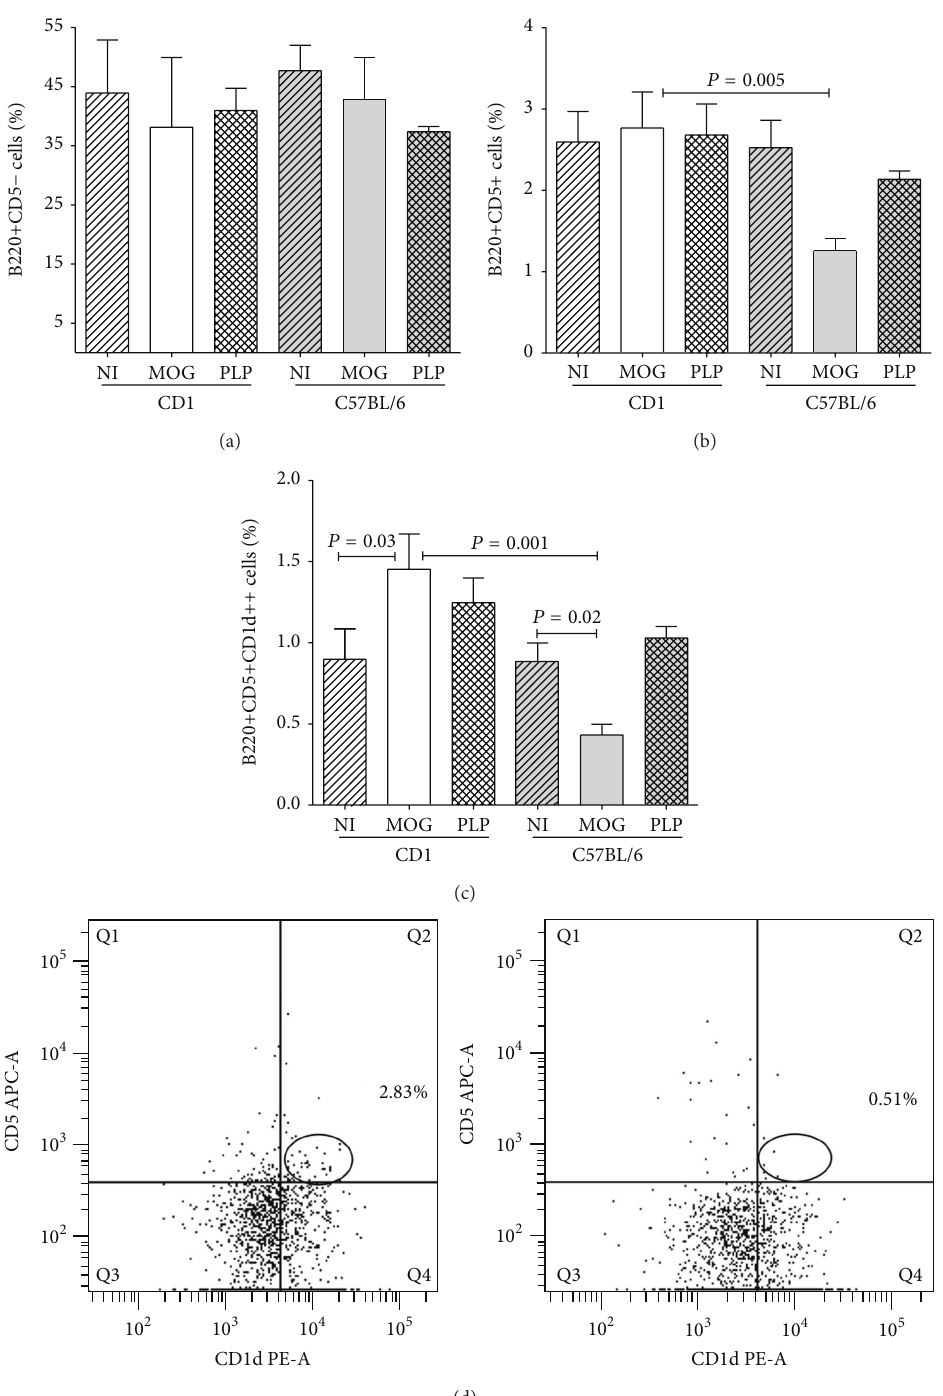
Figure 2: Effector and regulatory B cells in spleens of C57BL/6 and CD1 mice. We analyzed these cells in series of seven mice per condition. (a) B2 cells (B220+CD5 − ) did not change significantly in mice immunized with MOG 35−55 (MOG) or PLP 139−151 (PLP) when compared with nonimmunized (NI) ones. (b) B1 cell (B220+CD5+) percentage diminished in C57BL/6 mice that developed EAE upon immunization with MOG 35−55 . (c) The B220+CD5+CD1d hi regulatory subset (Breg) increased in resistant CD1 mice immunized with MOG. Conversely, it decreased in susceptible C57BL/6 mice developing EAE after immunization with the same peptide. (d) Representative dot plots showing Breg induced in CD1 (left side) and C57BL/6 (right side) mice upon immunization with MOG 35−55 peptide. Total B cells were gated by selecting B-220 positive cells and then Breg were identified by CD5 and CD1d hi